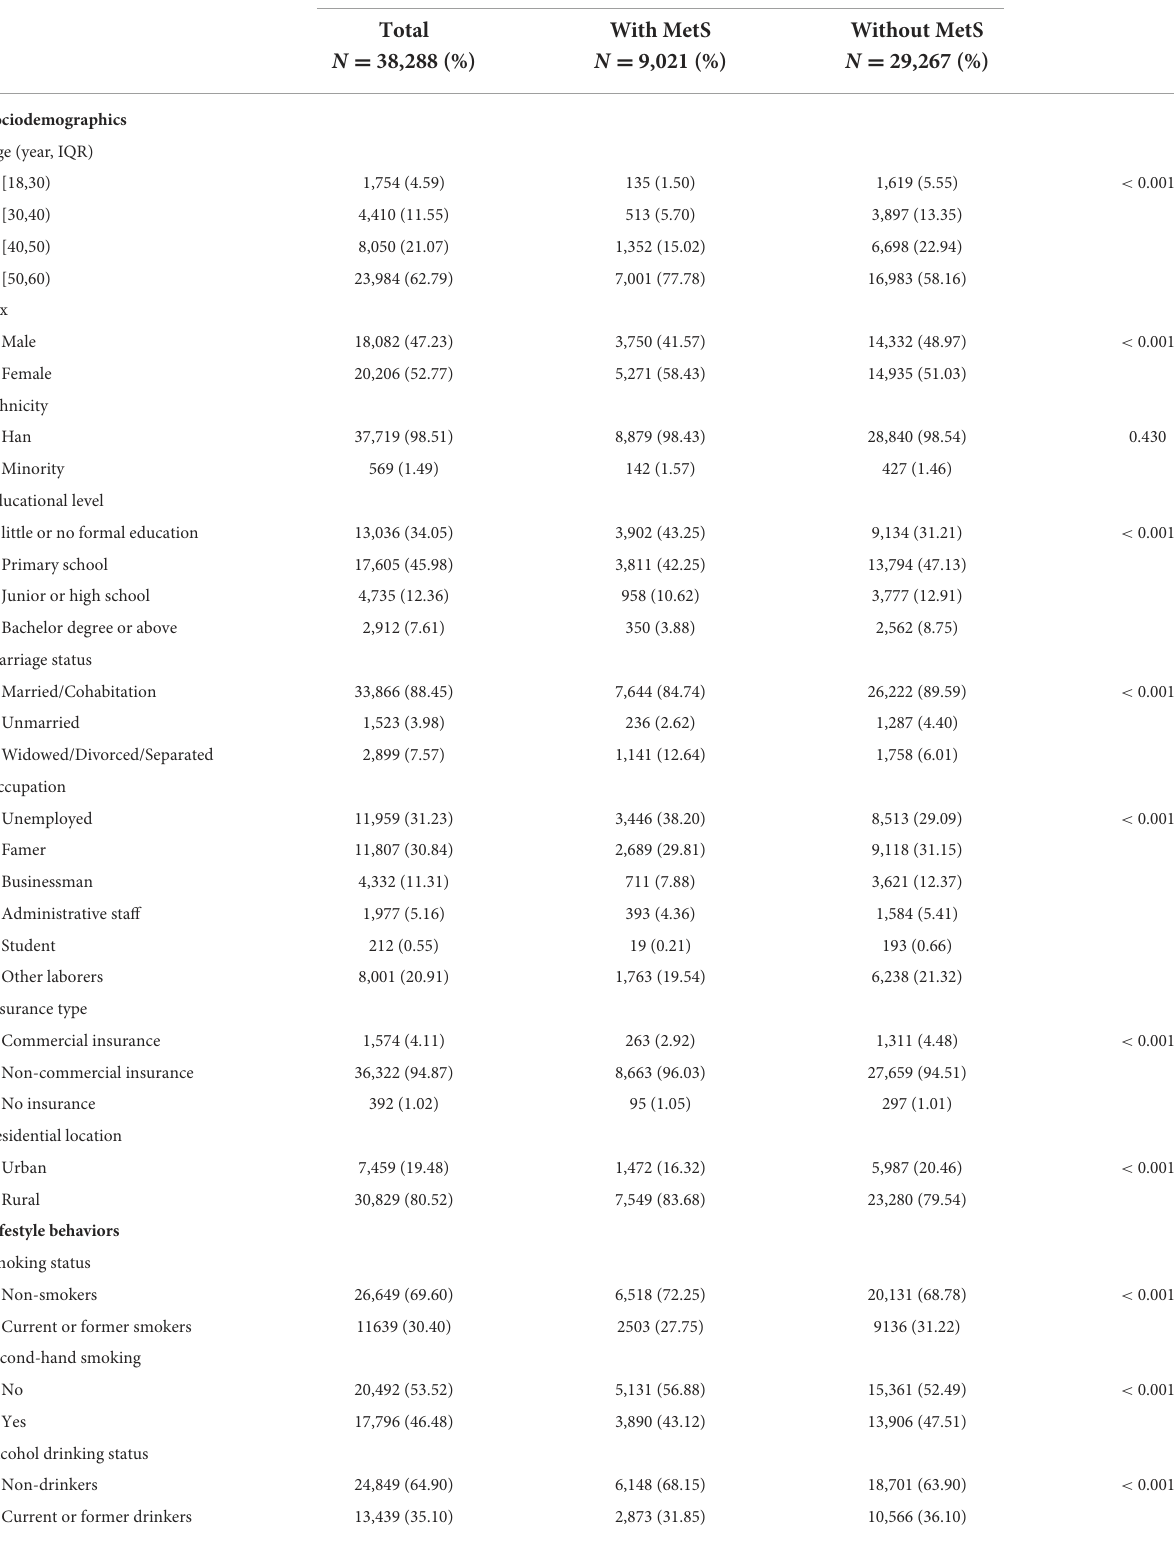
TABLE 1 Characteristics of the study